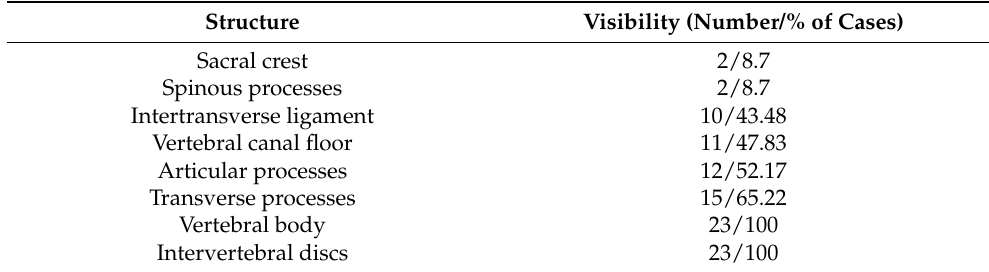
Table 2. Structures identified in the study in the longitudinal plane and the number and percentage of their visibility in the examined cadavers.